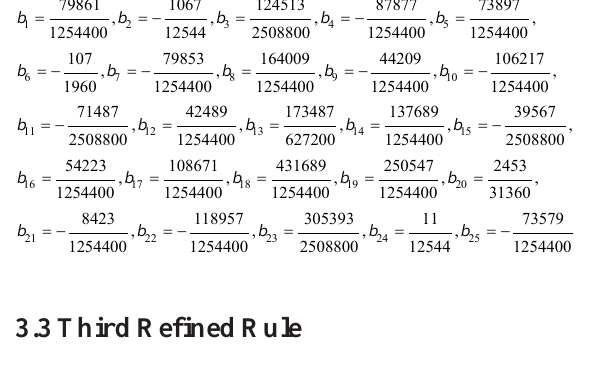
Fig. 2(a) shows the four new points 1 2,21 2,121 12,21 k jik jik jik ,,,    pppp corresponding to face of 12,12 ji  coarse mesh. Similarly, corresponding to each face of the coarse mesh four new points are introduced. These points are connected to get the part of refined